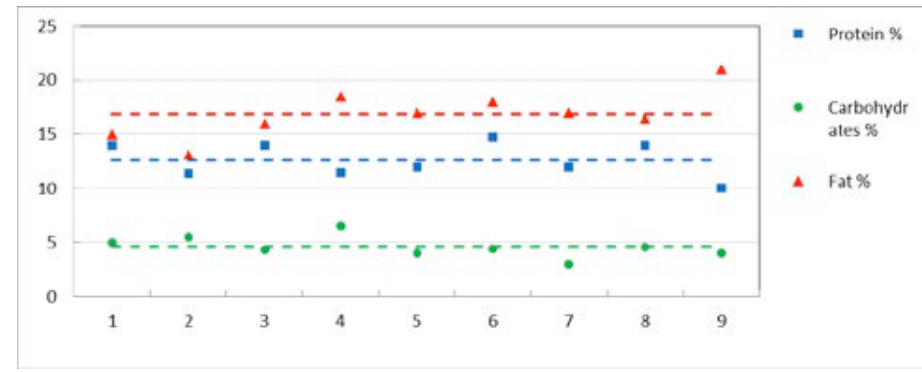
Figure 3. Distribution around average value of variables (protein, carbohydrates, fats).